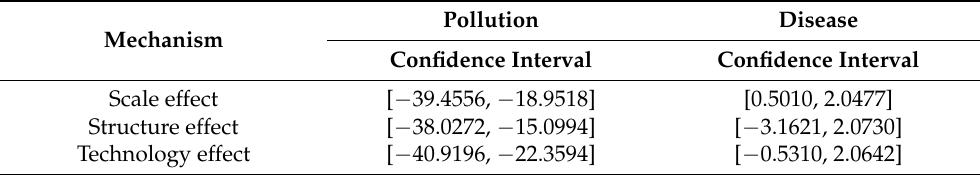
Table 8. Bootstrap